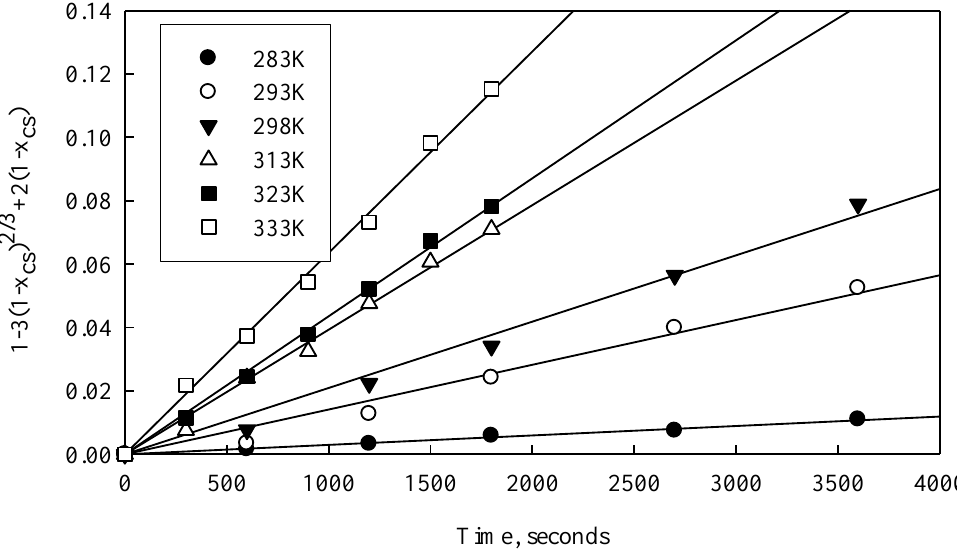
Figure 12. Leaching kinetics of converter slag using the data in Figure 6.